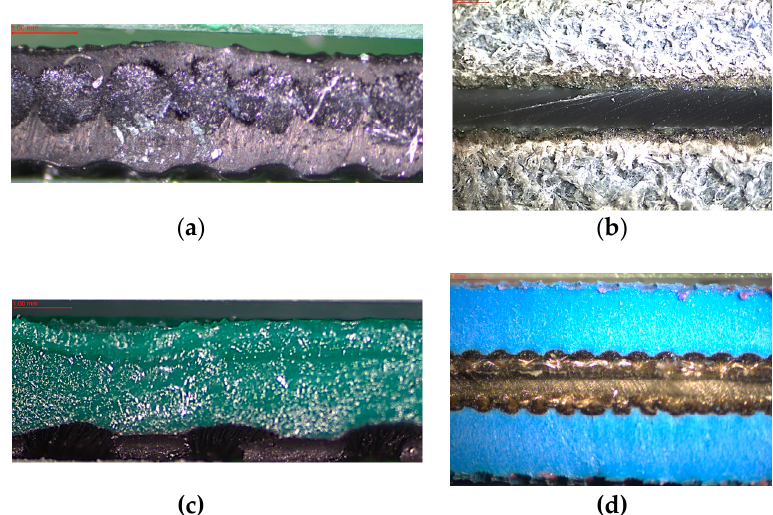
Figure 1. Optical light microscopy micrographs of flat belts: ( a ) NE22, ( b ) LL2, ( c ) TC, and ( d ) XH (magnification 20 × ).